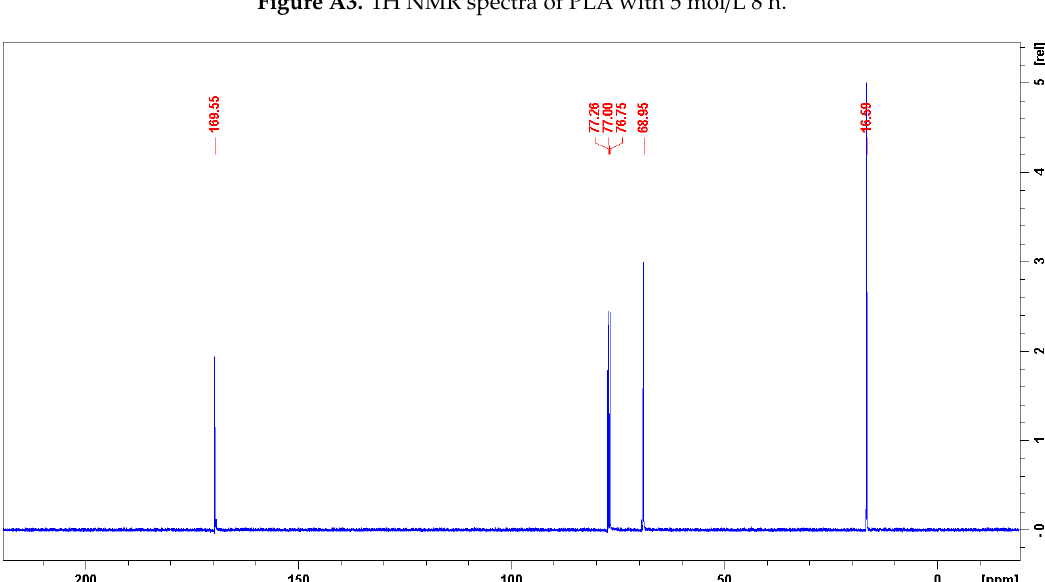
Figure A4. 13C NMR spectra of PLA with 5 mol/L 8h.